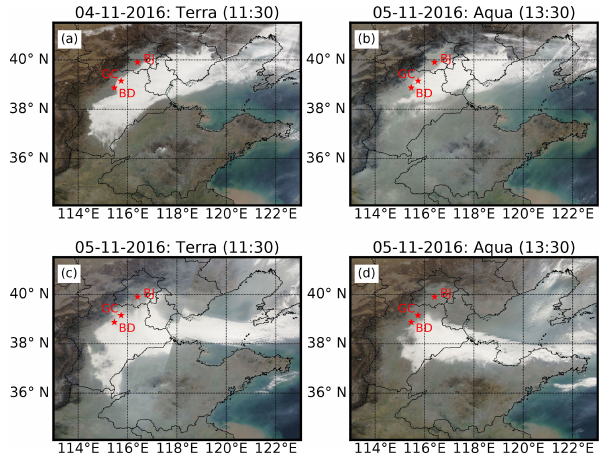
Figure 1. MODIS Terra (a, c) and Aqua (b, d) satellite images on 4 November (a, b) and 5 November 2016 (c, d) ; the star markers represent the locations of Gucheng (GC: the observation site), Baoding (BD) and Beijing (BJ). The original MODIS images were downloaded from https://worldview.earthdata.nasa.gov/ (last access: 18 September